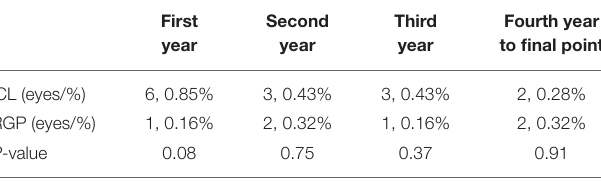
TABLE 3 | RRD incidence in different years after refractive